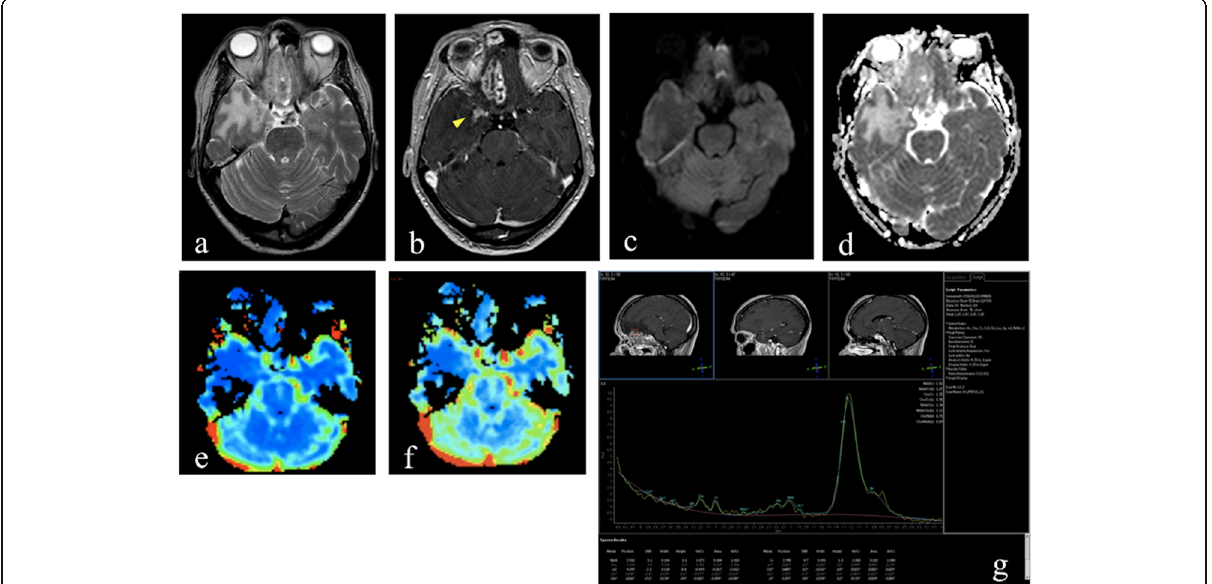
Fig. 1 MRI performed 16 months after carbon ion therapy of a sino-nasal adenoid-cystic carcinoma. T2-weighted image ( a ) shows an extensive area of altered signal intensity involving right gyrus rectus, polar and mesial temporal regions. Axial postcontrast T1-weighted image ( b ) shows two different areas of enhancement: a focal area of enhancement without necrosis, surrounded by edema, as a grade 1 injury of Late Effects Normal Tissue Task Force subjective, objective, management and analytic (LENT-SOMA) scoring system in right mesial temporal region (yellow arrowhead); a larger area with non-enhancing portion of necrotic tissue with peripheral rim enhancement, surrounded by edema, in right gyrus rectus. The axial diffusion weighted (DWI) image ( c ) and apparent diffusion coefficient (ADC) map ( d ) show no diffusion restriction within the enhancing area with an evident hyperintense area in ADC map. Cerebral blood flow (CBF) ( e ) and relative cerebral blood volume (rCBV) ( f ) maps show no hyperperfusion in the enhancing area. Magnetic resonance spectroscopy (MRS)-short TE ( g ) reveals the presence of high lipid and lactate peaks, which is typical of radiation